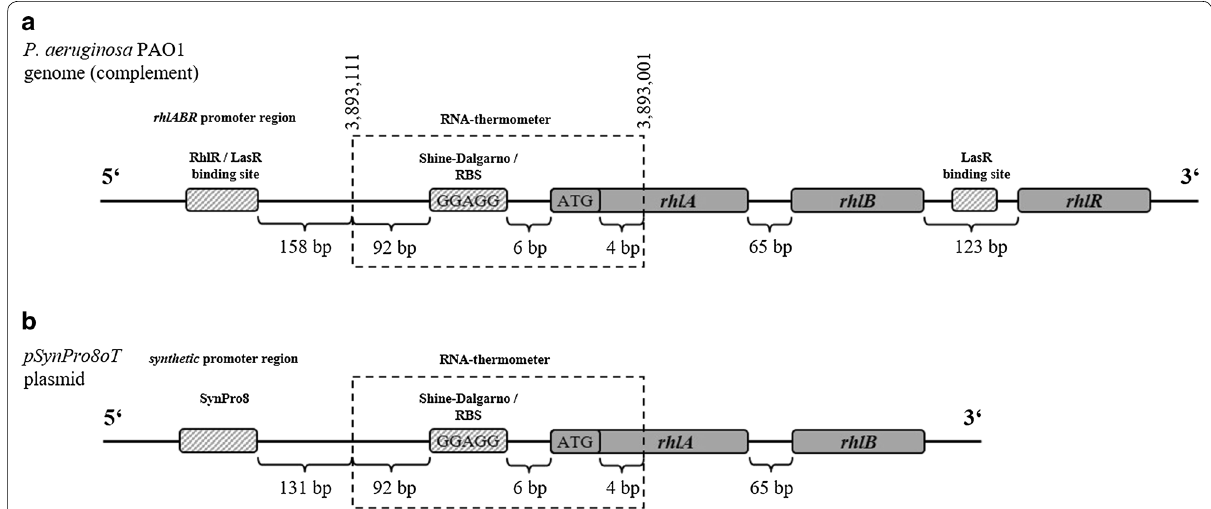
Fig. 1 Comparison of DNA sequences of the rhlAB operon with a ROSE-like element RNA-thermometer located in the 5 ′ UTR of native ( a ) and heterologous ( b ) rhamnolipid production hosts P. aeruginosa PAO1 and Pseudomonas putida KT2440 pSynpro8oT_ rhlAB (Beuker et al.